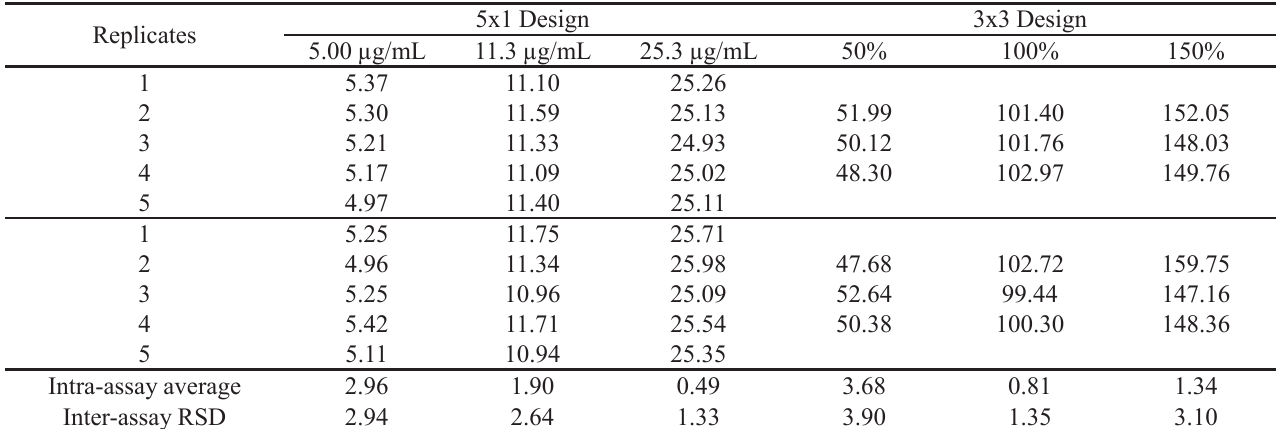
TABLE II - Results of potency of solutions of different concentrations of gramicidin determined by agar diffusion method to study precision and accuracy